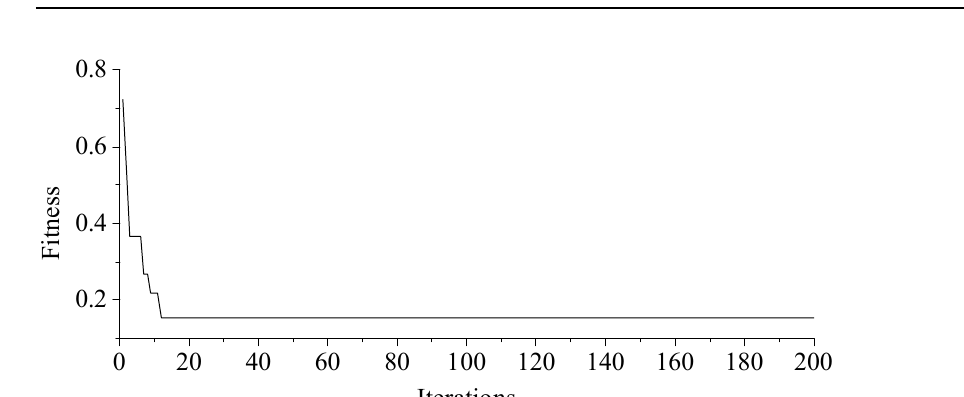
Figure 5. Iteration process of the DE algorithm. The value of each parameter under the optimal solution is, β = 23.81°, d 1 = 358 mm, h = 617.43 mm, and Q = 0.6 km 3 /h. Numerical calculation of the optimization results shows that the result is 16.18% and the power consumption of the impeller is 163.3 W. Under the optimal solution, the coefficient of variation is CV = 16.02% and the error compared with the numerical calculation is 1.02%. The consumed power of impeller P = 163.5 W and the error is less than 1%.